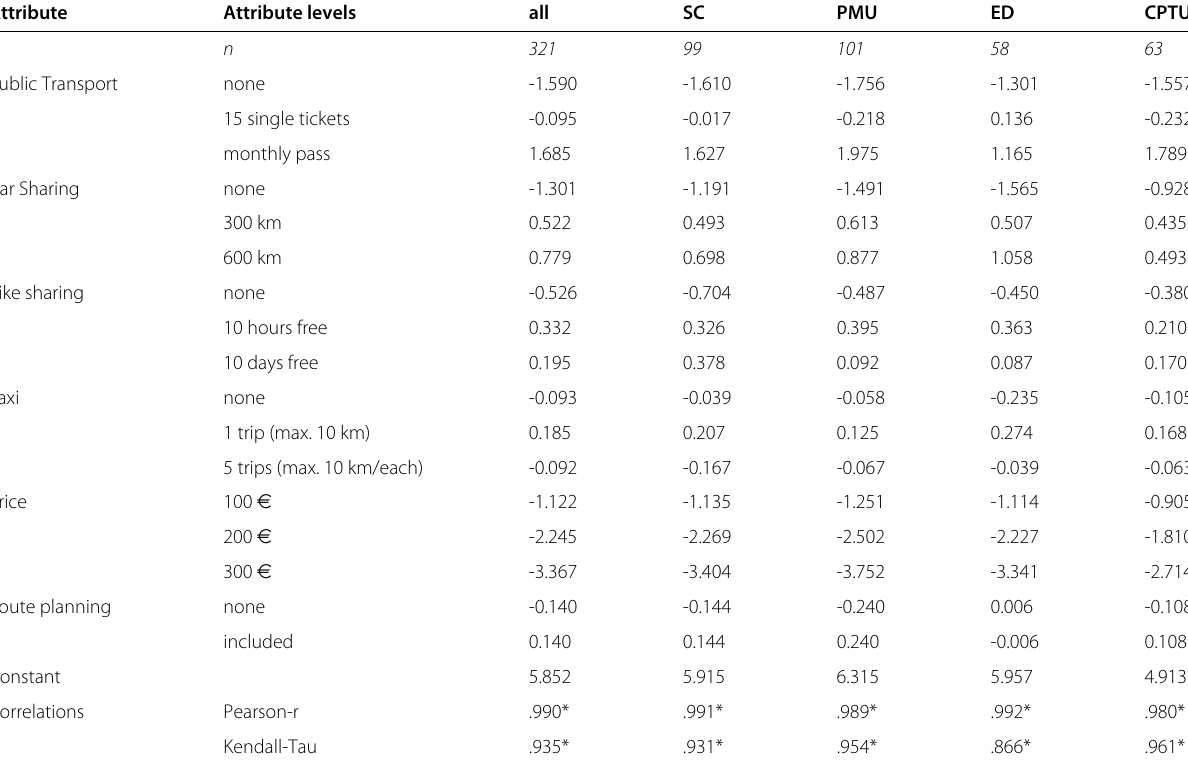
Table 7 Results of the conjoint